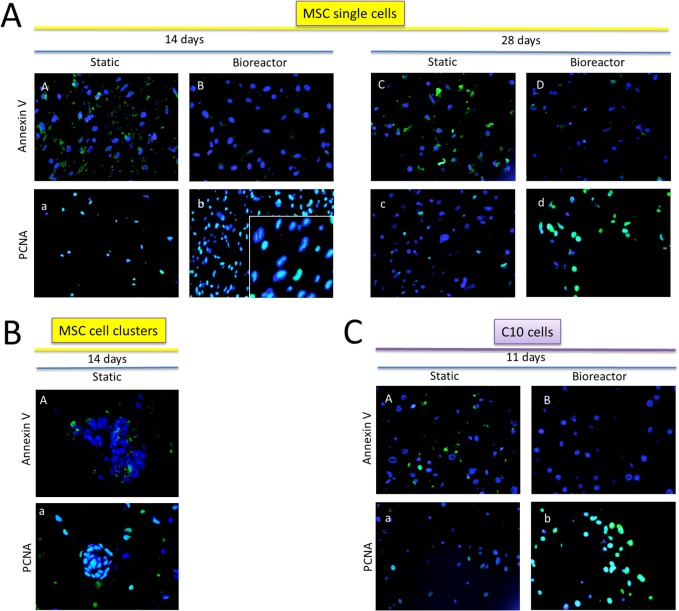
Annexin V and PCNA staining of decellularized lung scaffolds recellularized with (A) MSCs in static versus bioreactor conditions for 14 (panels A, B for annexin V, and a, b for PCNA) and 28 days (panels C, D for annexin V, and c, d for PCNA) (single cells), (B) MSC cell clusters in static conditions at 14 days (panel A for annexin V, and a for PCNA), (C) C10 cells in static (panel A for annexin V, a for PCNA) versus bioreactor (panel B for annexin V, b for PCNA) conditions for 11 days.An inset in Fig 4Ab with higher magnification is shown to demonstrate that a majority of the cells stained positive for PCNA. Cell nuclei are labeled in blue; marker of interest is labeled in green. Magnifications are 400x. Overlap of cell nucleus and marker of interest can generate green or white color. For each condition, images are representative of the entire lung.